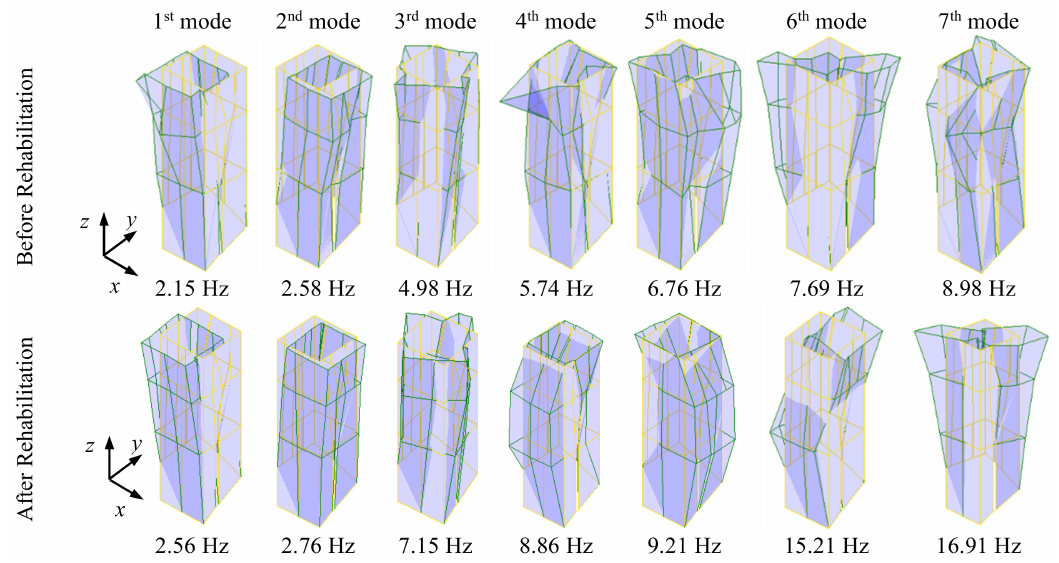
Figure 6. Experimental mode shapes of the Mogadouro clock tower—undeformed structure in yellow wireframe (reprinted with permission from Ref. [49]. Copyright 2018,